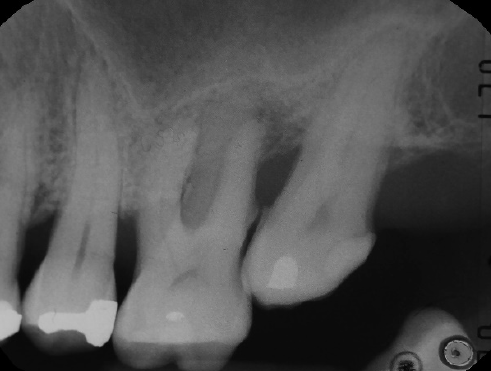
Figure 1. Patient in therapy with oral bisphosphonates for osteoporosis. Initial intraoral radiography.